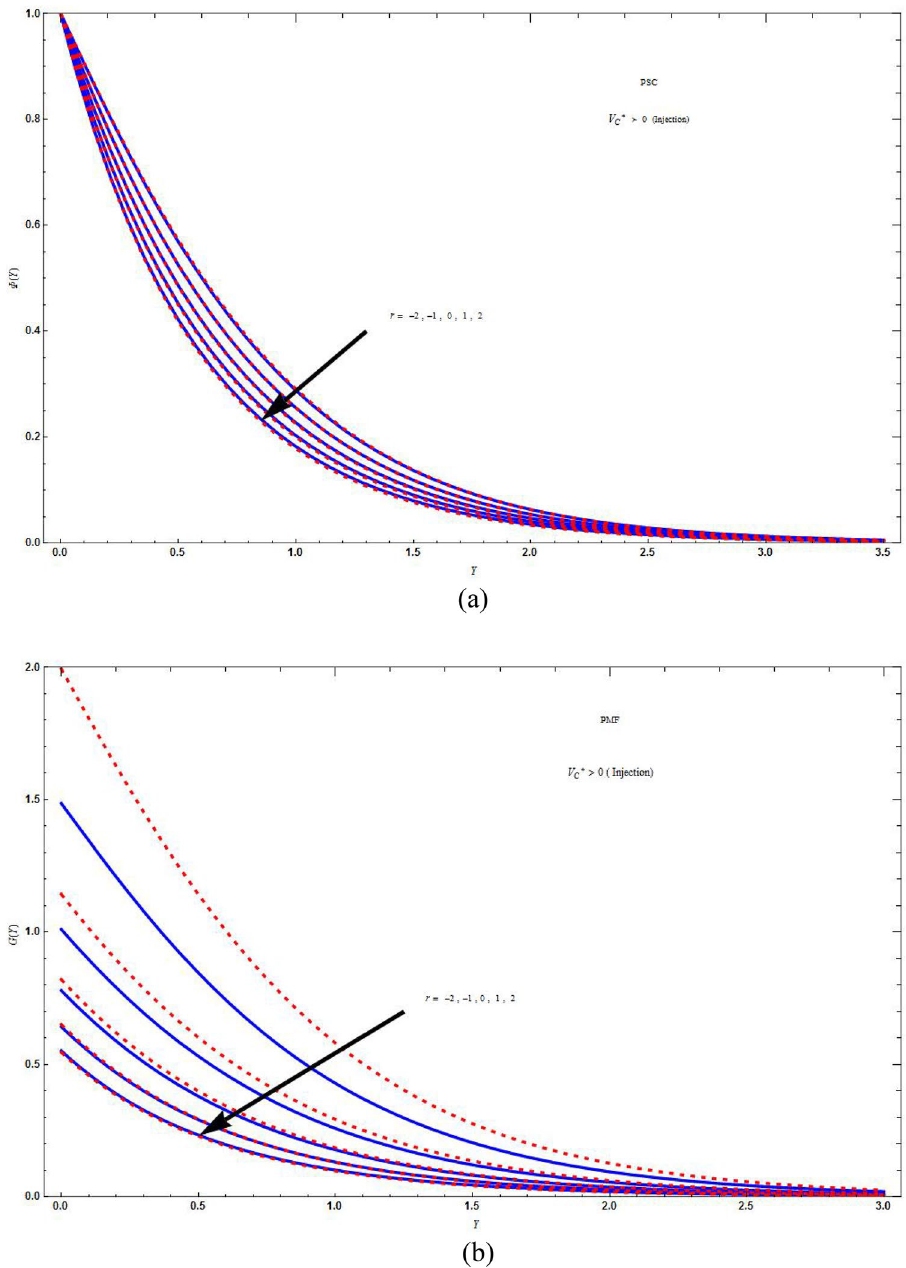
Figure 4. The concentration distribution plot for